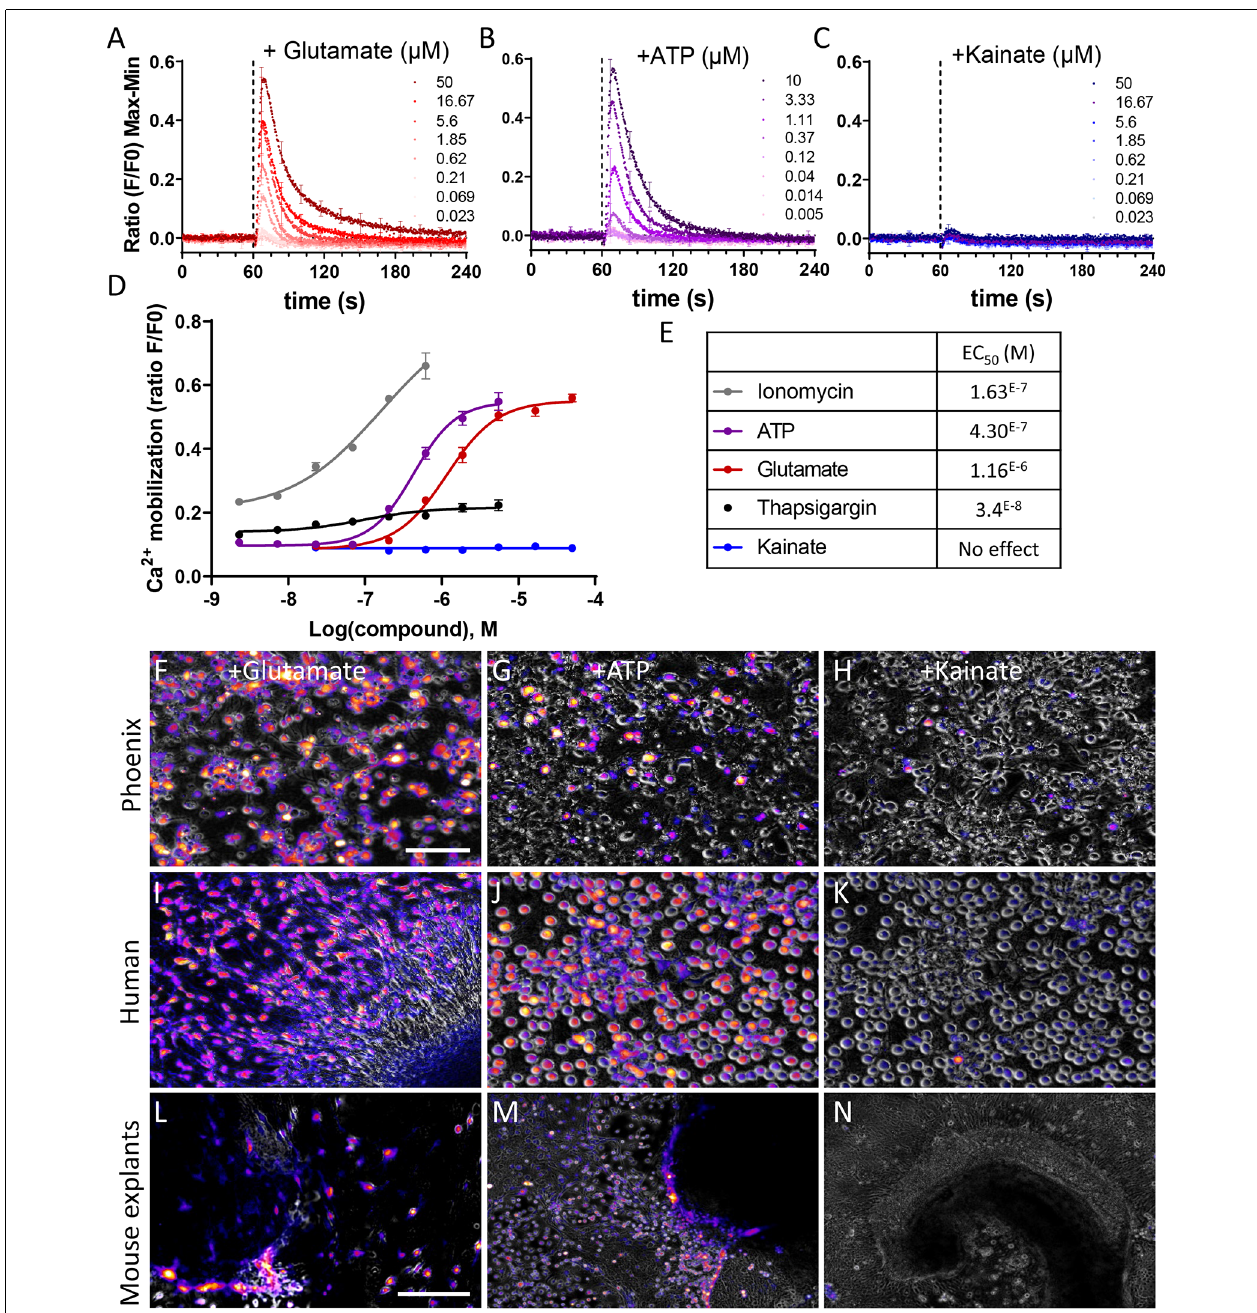
FIGURE 7 | Phoenix and human fetal auditory neurons exhibit glutamatergic and purinergic Ca 2+ transients. (A–C) Kinetics of Ca 2+ transients induced by (A) glutamate, (B) ATP, (C) kainate in phoenix auditory neurons after 7 days of differentiation. Phoenix auditory neurons were loaded with Ca 2+ -sensitive ratiometric probe (FLUO-8) and stimulated with increasing concentrations of glutamate (0.02–50 µ M), ATP (0.005–10 µ M), or kainate (0.02–50 µ M). (D) Dose–response curves were extracted from the max–min amplitude values, allowing the determination of an EC 50 value (E) Ionomycin and thapsigargin were used as positive control. Data represent the average ± SEM of three independent experiments. (F–N) Live Ca 2+ imaging of (F–H) phoenix auditory neurons, (I–K) human sphere-derived auditory neurons, and (L–N) mouse cochlear explants following stimulation with 100 µ M glutamate (F,I,L) , ATP (G,J,M) , or kainate (H,K,N) . The magenta color represents cells where Ca 2+ mobilization was induced. (F–K) Scale bar: 100 µ m; (L–N) scale bar: 500 µ m. Data are representative of three independent experiments.